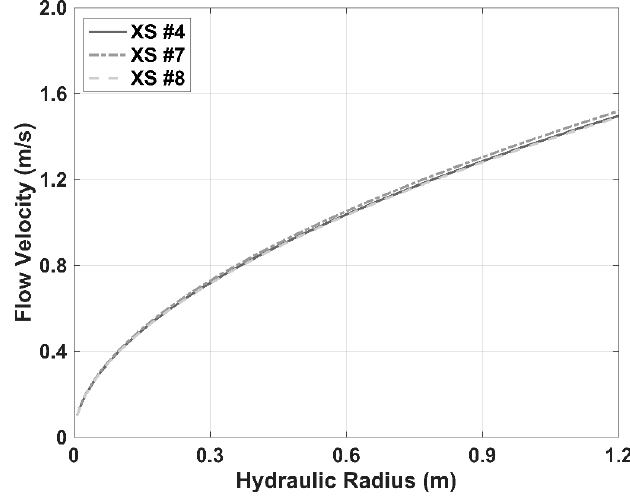
Figure 3. Stage-discharge predictor curves developed for cross-sections XS #4, XS #7, and XS #8 following the methodology proposed by Brownlie [47] for sand-bed channels.